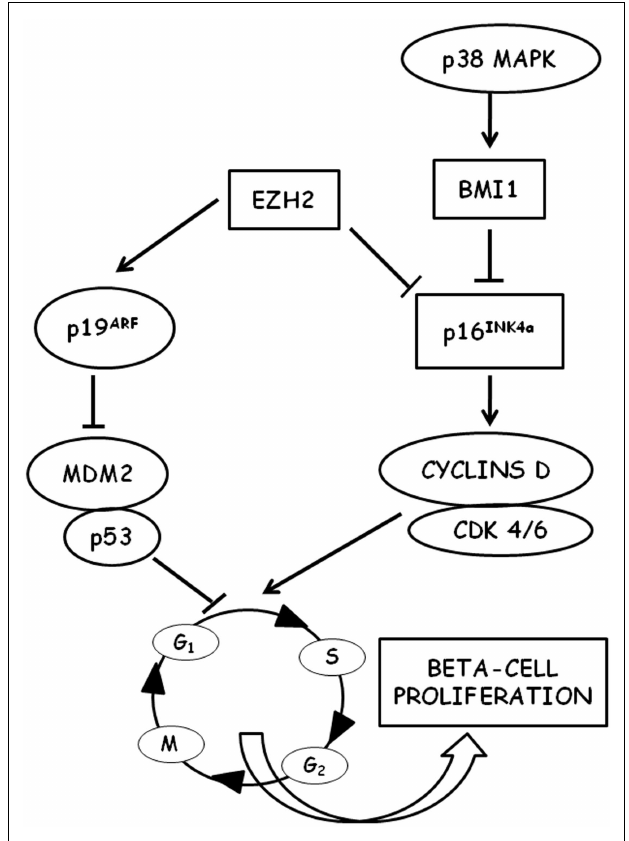
FIGURE 1 | Schematic representation of the molecular pathways involved in the regulation of beta-cell proliferation is shown . P16 INK4a is a key regulator of cell cycle entry in aged beta cells through D-type cyclins and cyclin-dependent kinases (CDK). P16 INK4a is negatively regulated by the polycomb proteins EHZ3 (enhancer of zeste homolog 2) and BMI1 (B lymphoma Mo-MLV insertion region 1 homolog). BMI1 is stimulated by p38